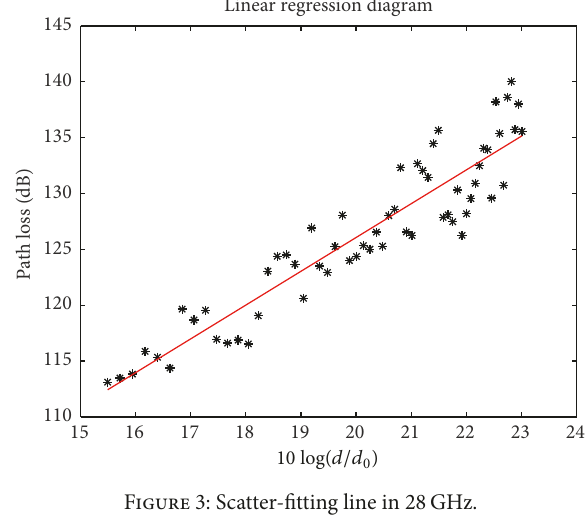
Figure 3: Scatter-fitting line in 28 GHz.